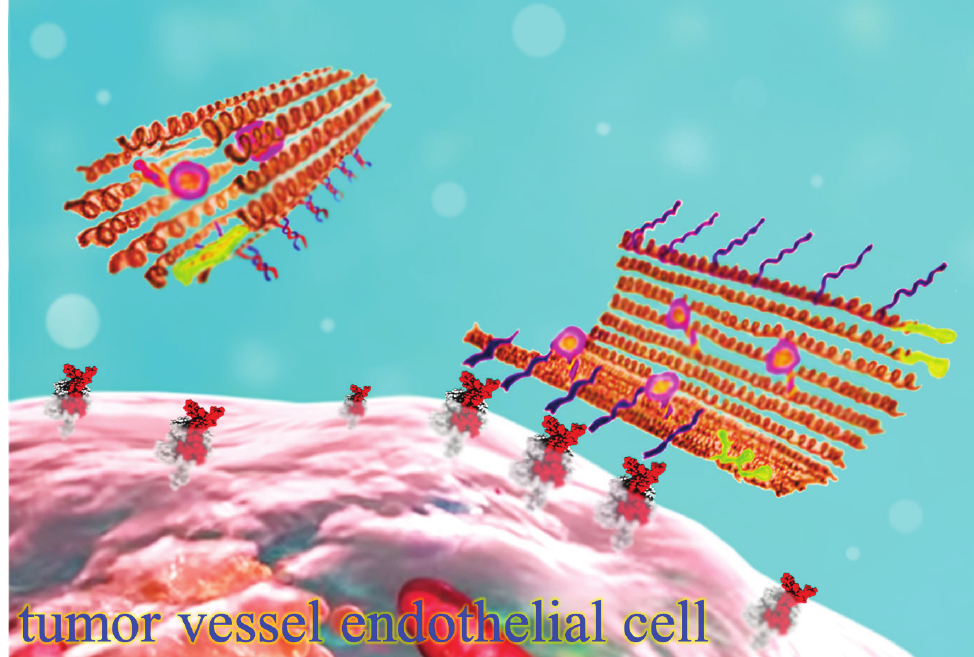
Figure 1. DNA programmed nanorobot functionalized with aptamers for targeting and binding to protein biomarkers expressed on the tumor-associated endothelial cells. The attached antibodies are the key for the mechanism to open the tubular-origami shape and performing of massive blood coagulation at the tumor